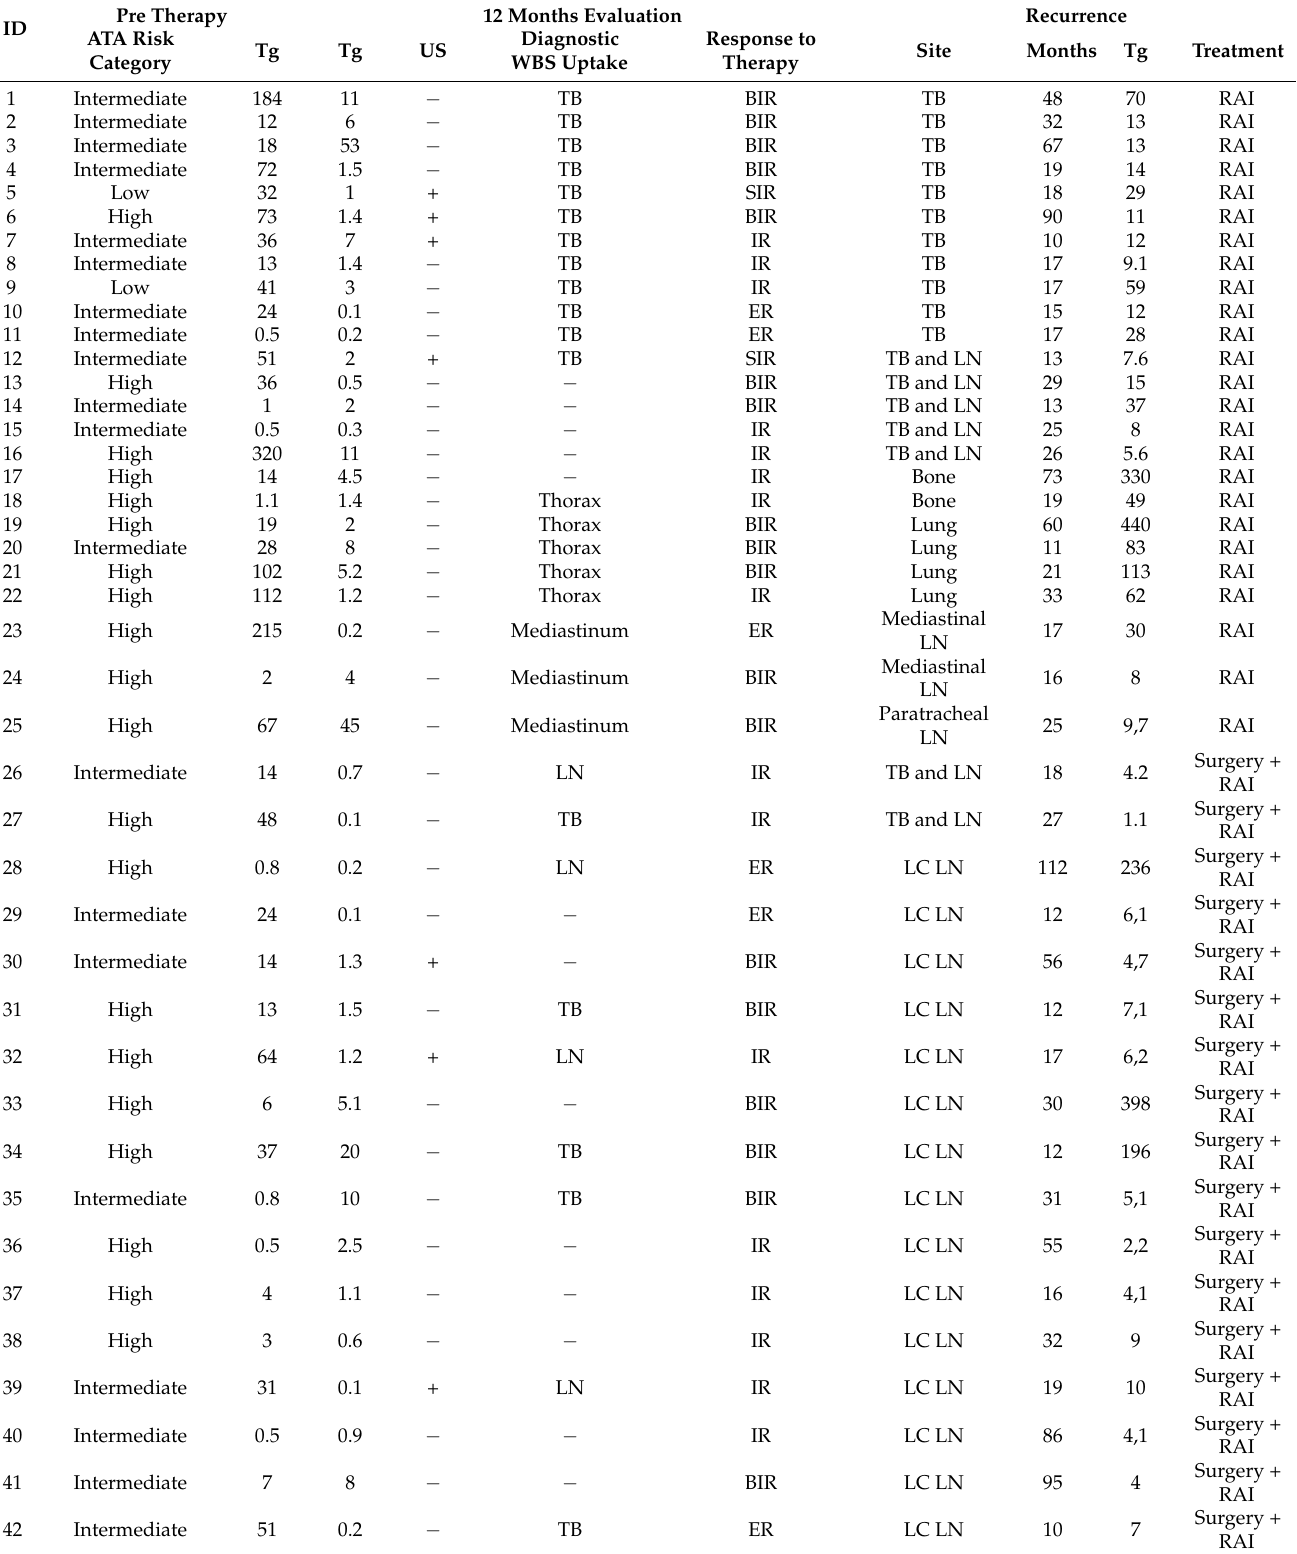
Table 3. Characteristics of 42 patients with events at the time of